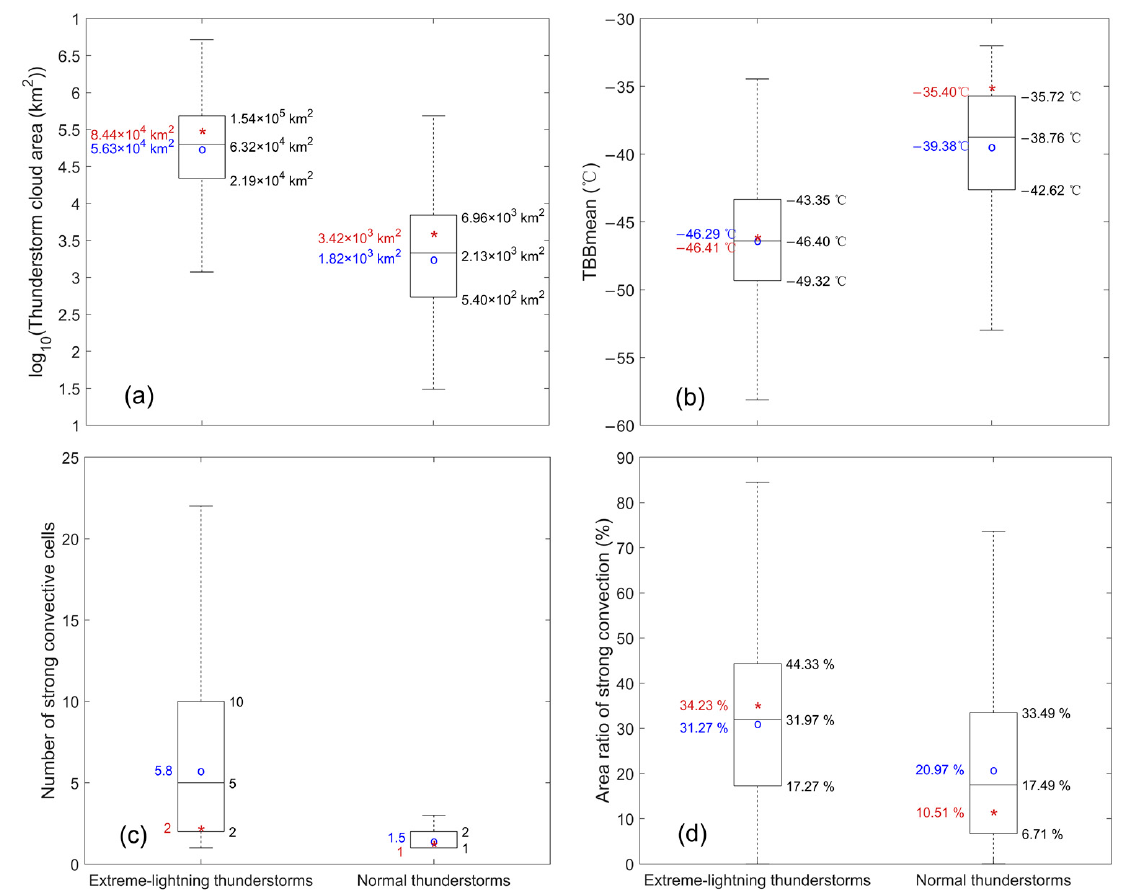
Figure 12. Comparison of structural parameters of extreme-lightning thunderstorms with those of normal thunderstorms. ( a ) Cloud area; ( b ) average TBB; ( c ) number of strong convective cells; ( d ) area ratio of strong convection. The blue “o” represents the mean value, and the red “*” represents the distribution peak, which is obtained by the method of kernel density estimation (KDE).